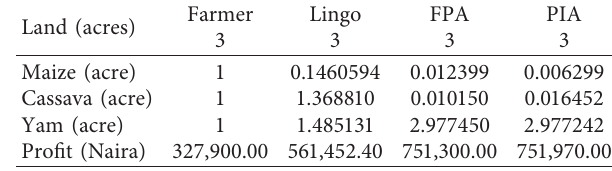
Table 4: Result of crop acreage and profit obtained from the model.